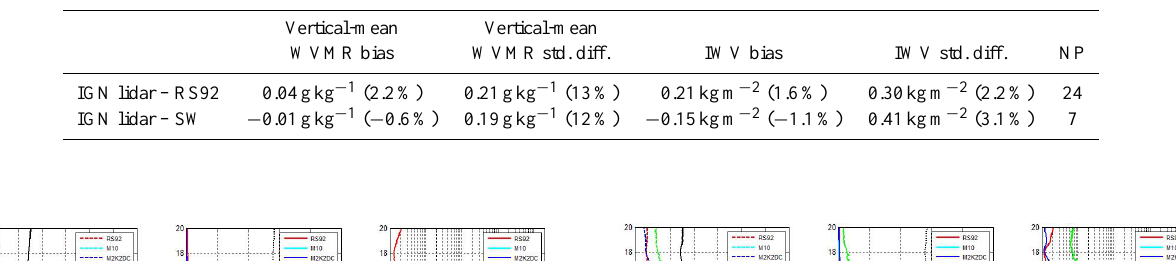
Table 3. Statistical results of comparison of WVMR measurement between IGN-LATMOS lidar and radiosondes (RS92 and Snow White). Mean difference (bias) and standard deviation of difference (std. diff.) are temporal statistics computed over NP profiles. The IWV values for this comparison are computed over the common lidar and radiosonde altitudes (0.85–10km).